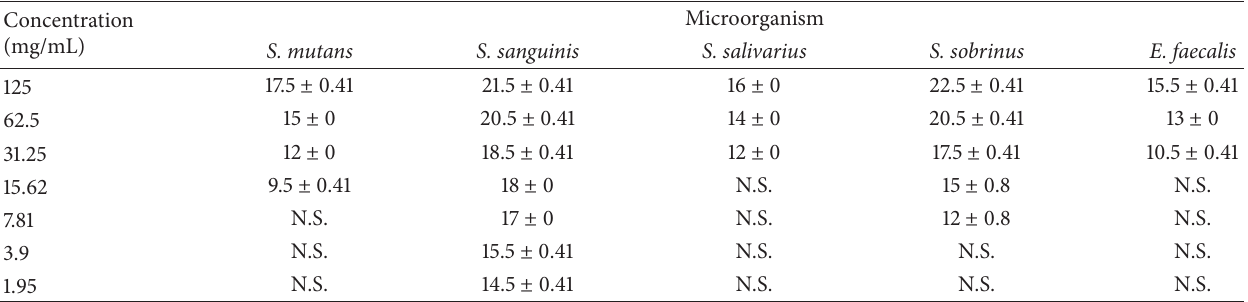
Table 1: The mean and SD of the diameter of growth inhibition zone (mm) due to the effect of the hydroalcoholic extract of P. granatum petal on different microorganisms.